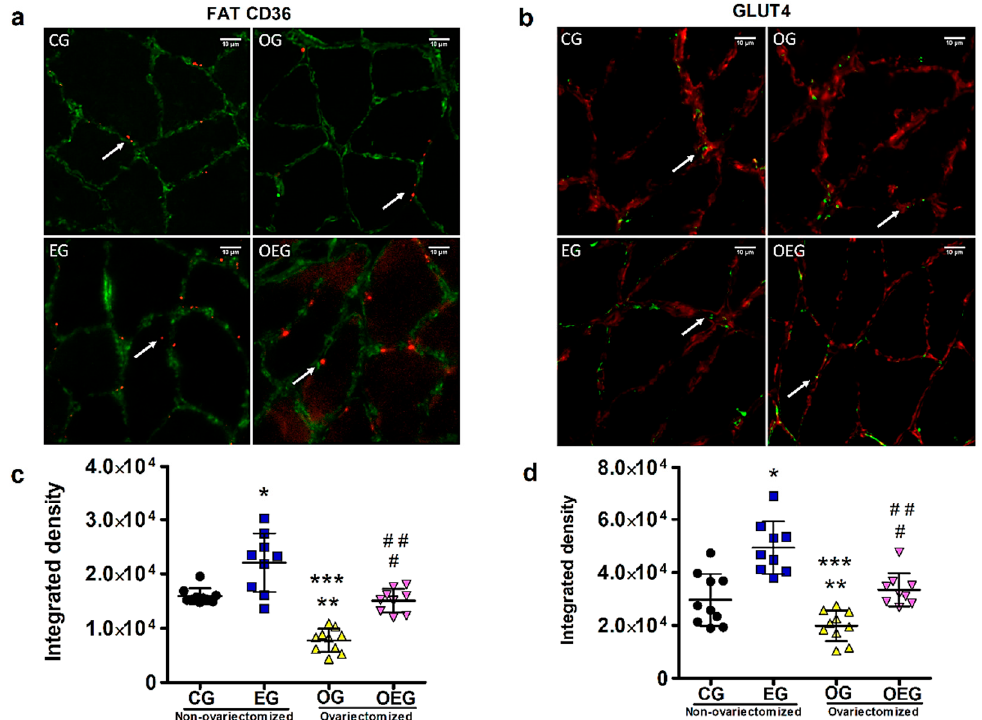
Figure 1. Representative immunofluorescence images from tissue sections: ( a ) laminin (green) and FAT CD36 (red) in soleus skeletal muscle and ( b ) laminin (red) and GLUT4 (green) in soleus skeletal muscle in the control group (CG; n = 10), ovariectomized group (OG; n = 10), exercised group (EG; n = 9), and ovariectomized and exercised group (OEG; n = 9). The white arrows indicate the proteins, FAT CD36 in the panel ( a ) and GLUT4 in the panel ( b ). Graphs represent the average from integrated intensity values of FAT CD36 ( c ) and GLUT4 ( d ) expressions obtained from each animal. Data are represented as mean and standard deviation. The statistics provided in the graphs are the results of the Newman–Keuls post hoc test: * p < 0.05 EG in relation to CG; ** p < 0.05 OG in relation to CG; *** p < 0.05 OG in relation to EG; # p < 0.05 OEG in relation to EG; ## p < 0.05 OEG in relation to OG. For illustrative images objective lens = 20 × was used; scale bar = 10 µm.